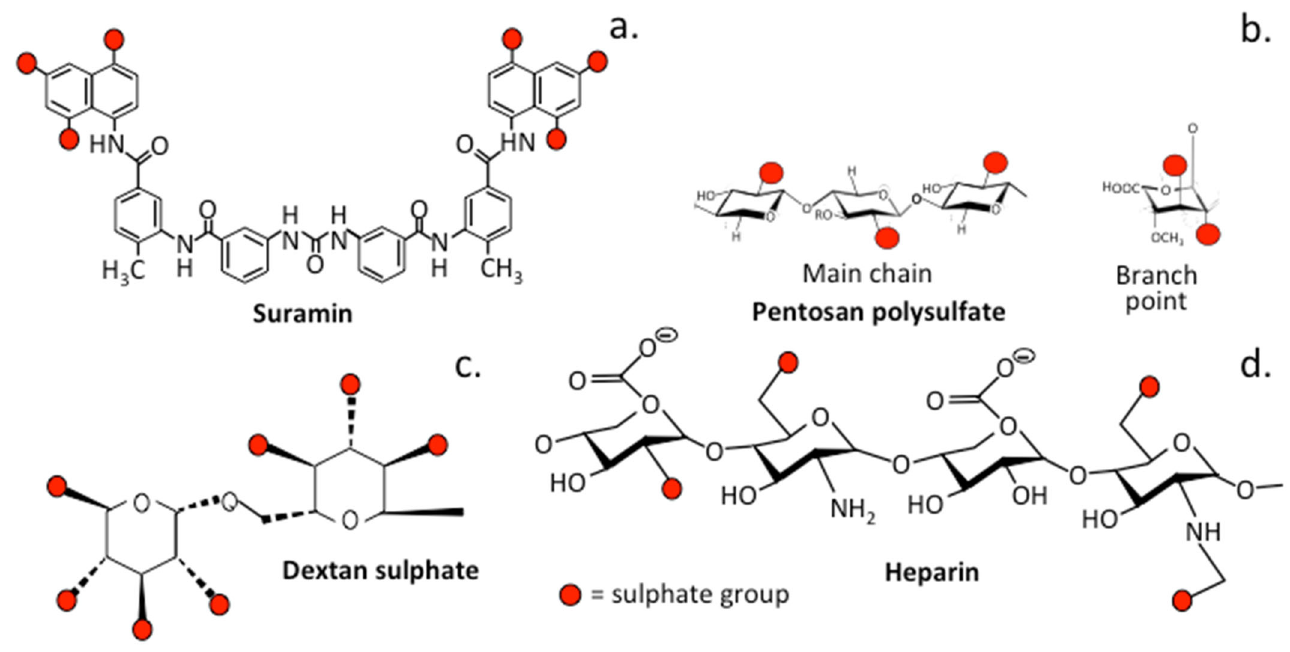
Figure 2. Structures of the sulfated glycopolymers suramin ( a ), PPS ( b ), dextran sulfate ( c ) and HS ( d ), showing their sulfation positions. See Figure 1 for details of an intact PPS chain.